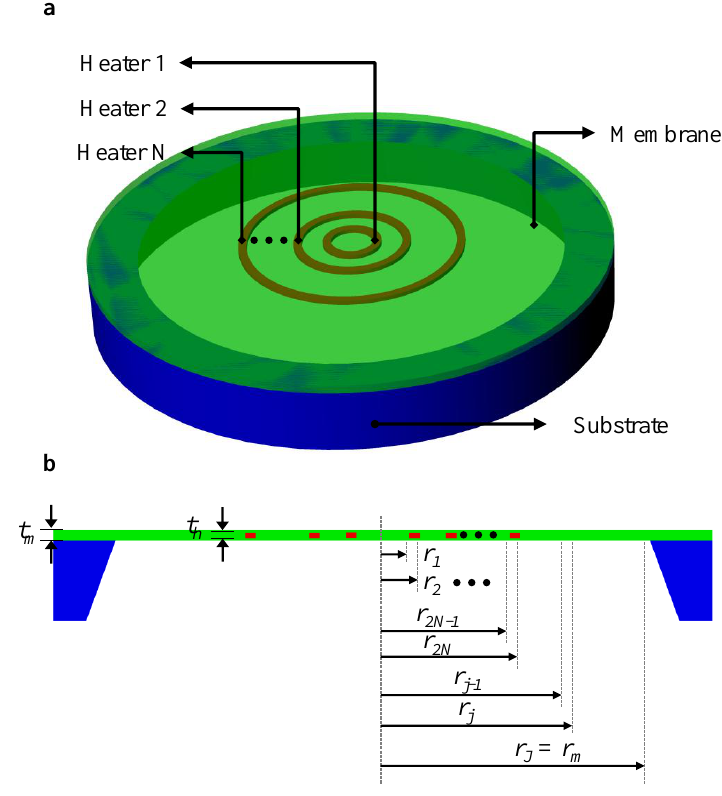
Figure 3. Perspective ( a ) and cross-sectional ( b ) views of a circular-symmetric micro-hotplate with N